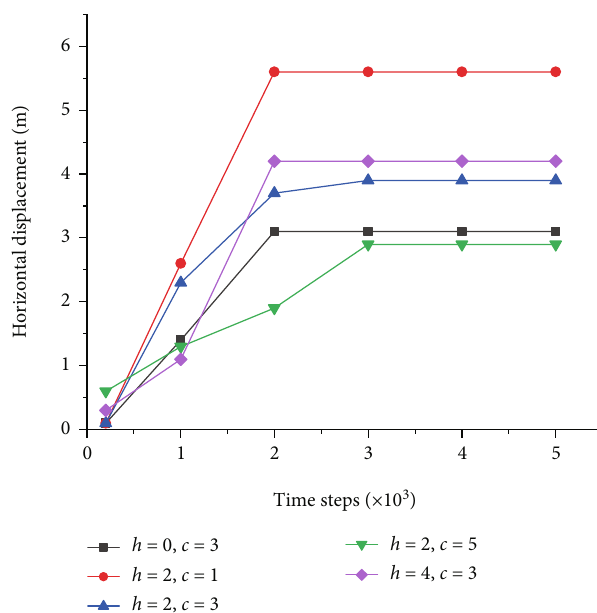
Figure 10: Horizontal displacement of the arch foot.